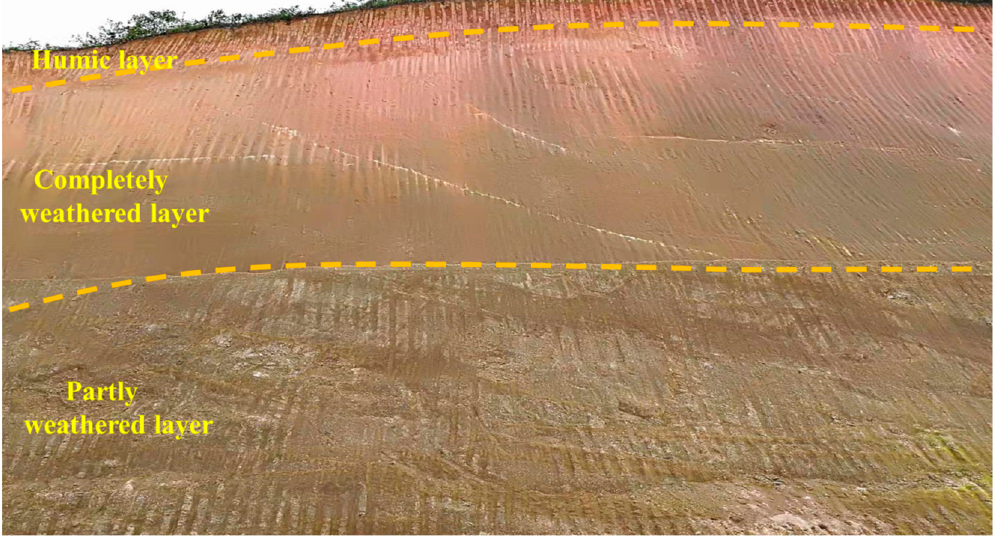
Figure 1. Pro fi le of weathered crust elution-deposited rare earth ore body. Figure 1. Profile of weathered crust elution-deposited rare earth ore